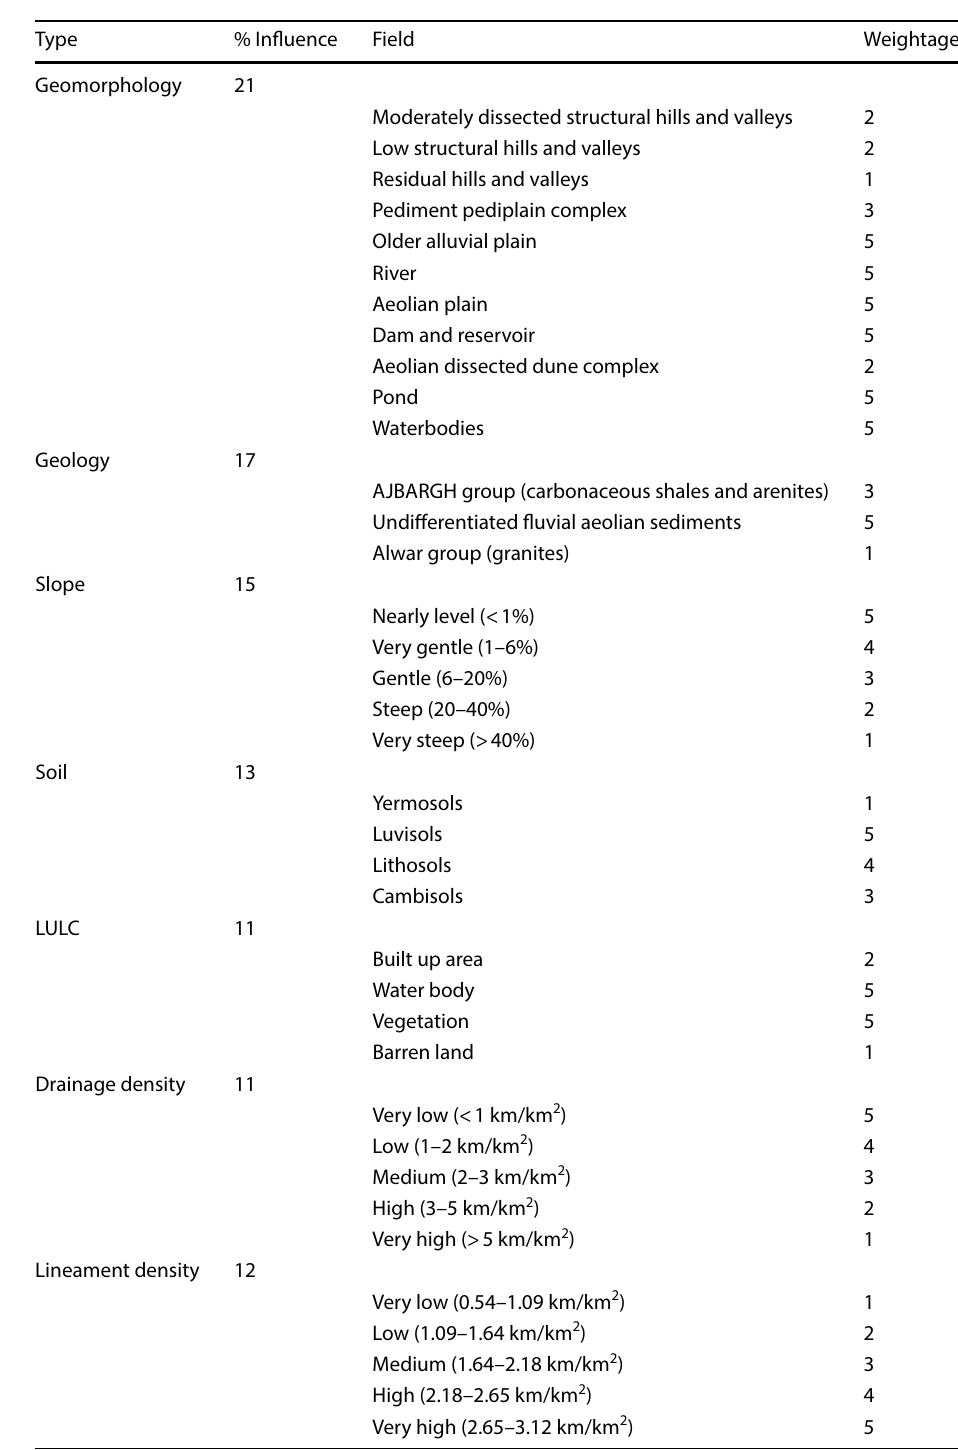
Table 1 Assigned weights and ranks for groundwater